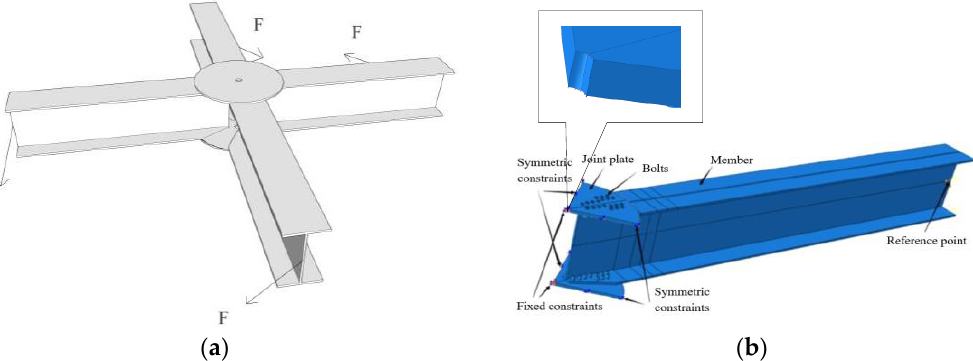
Figure 9. Comparison between theoretical model and FE model. ( a ) Full model; ( b ) quarter